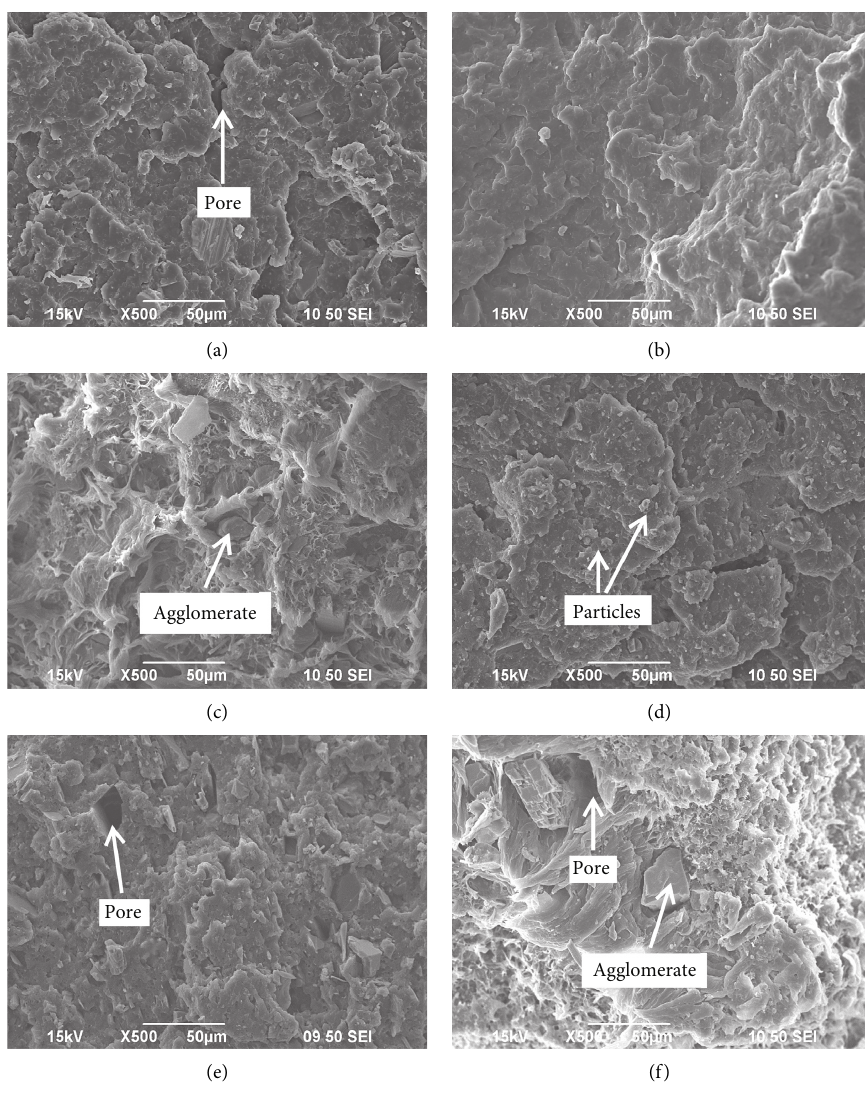
Figure 8: Scanning electron micrograph of the developed SSP/RWP composites and control. (a) Morphology of RWP, (b) morphology of 3 wt%, (c) morphology of 6 wt%, (d) morphology of 9 wt%, (e) morphology of 12 wt%, and (f) morphology of 15